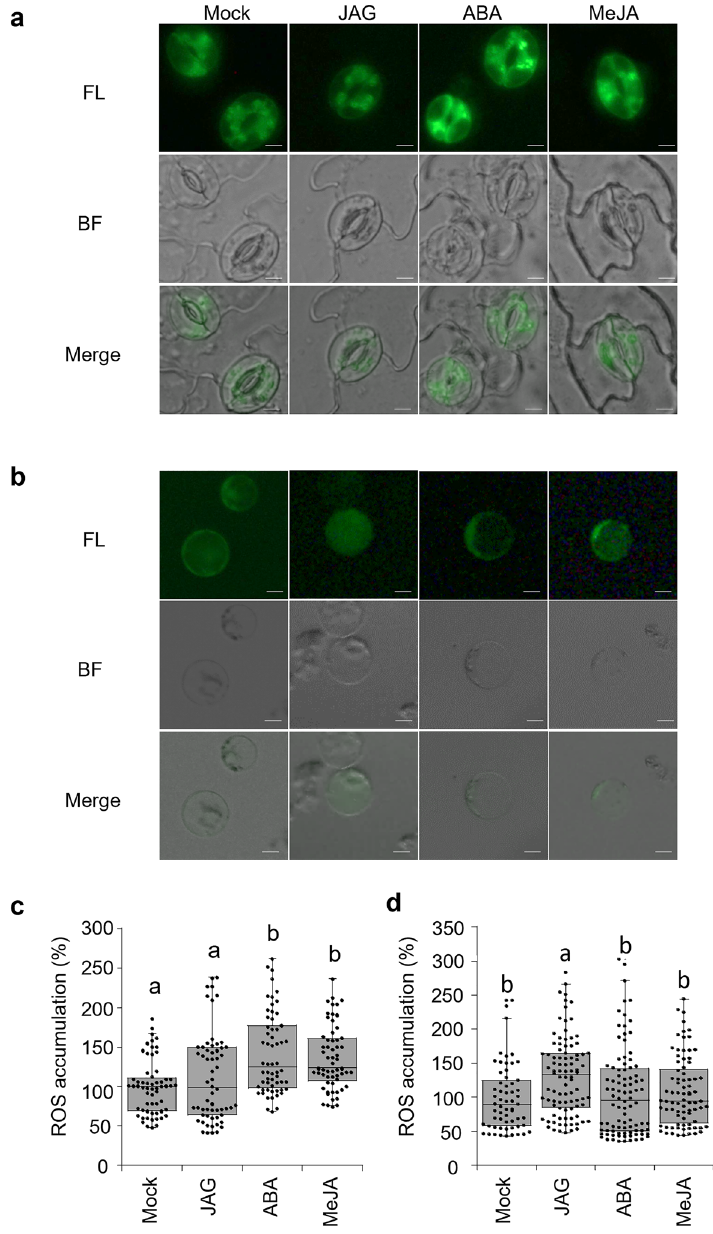
Figure 2. JAG induces ROS accumulation in tertiary extensor motor cell protoplasts of Samanea saman. ( a , b ) Representative images of reactive oxygen species (ROS) accumulation visualized by fluorescent dye DCF. ( a ) Epidermal peels of Arabidopsis thaliana or ( b ) tertiary extensor motor cell protoplasts of S. saman were loaded with H 2 DCFDA for 30 min before adding 100 µM 12-hydroxyjasmonic acid glucoside (JAG), 10 µM abscisic acid (ABA), or 10 µM methyl jasmonate (MeJA). Photomicrographs were taken 20 min or 15 min after treatment ( A. thaliana ) or at 15 min after treatment ( S. saman ). The experiments using S. saman protoplasts were performed during ZT 6–11. Bar = 10 µm. ( c ) Quantification of ROS accumulation in guard cells of A. thaliana following above treatment as in ( a ). Box plot represents fluorescence intensity ratio of treated cells to mock cells. All data are represented as dot plots (n = 60). Mean ± SE are as follows: Mock, 100.0 ± 4.5; JAG, 141.5 ± 6.5; ABA, 107.4 ± 3.9; MeJA, 111.9 ± 7.3. ( d ) Quantification of ROS accumulation in tertiary extensor motor cell protoplasts of S. saman following above treatment as in ( b ). Box plot represents fluorescence intensity ratio of treated cells to mock cells . All data are represented as dot plots (n = 61–92). Mean ± SE are as follows: Mock, 100.0 ± 6.4; JAG, 131.5 ± 5.9; ABA, 106.3 ± 6.7; MeJA, 108.4 ± 5.6. Different letters indicate significant differences (SNK post-hoc test, P < 0.05) in ( c ) and ( d